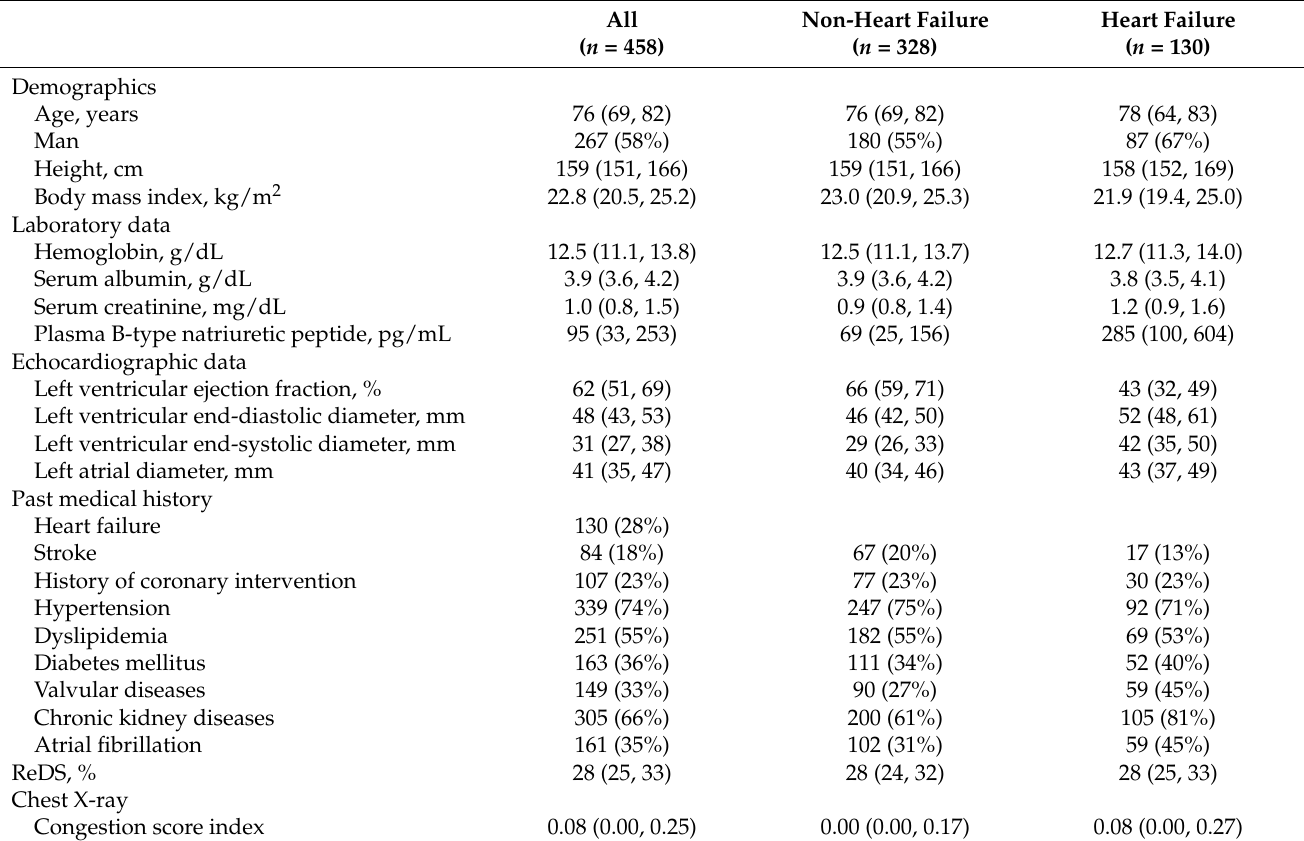
Table 1. Baseline characteristics.